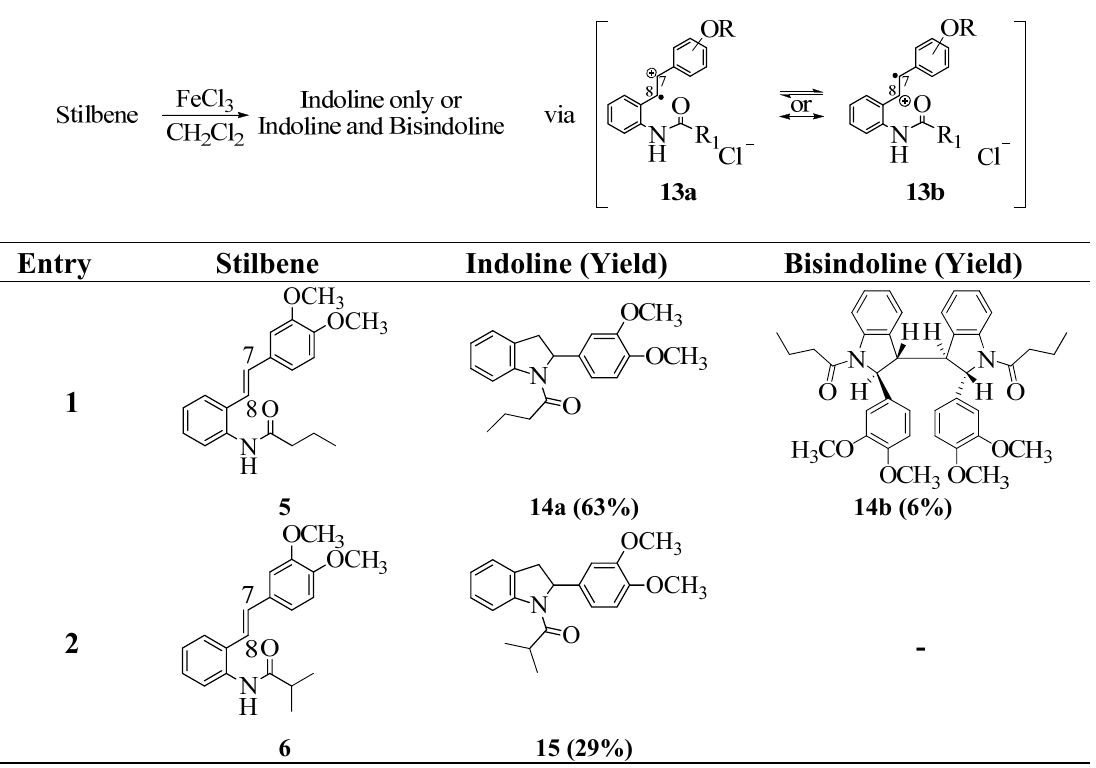
promoted syntheses of indolines and Table 2. FeCl 3